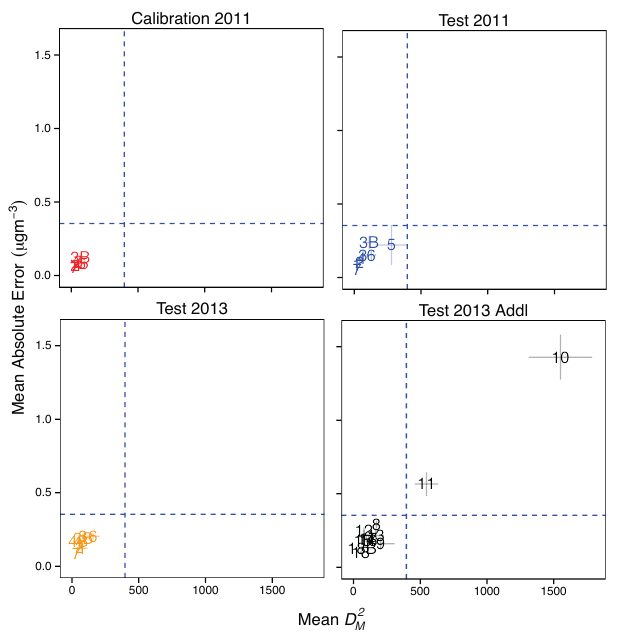
Figure 5. FT-IR OC. Anticipation of the prediction error. Mean squared Mahalanobis distance (between the scores of each data set described in Sect. 2.1 and the centroid of the calibration data set) against mean absolute error (between TOR OC and FT-IR OC). The measurements are aggregated per site. Each site is denoted with the site ID used in Table 1.